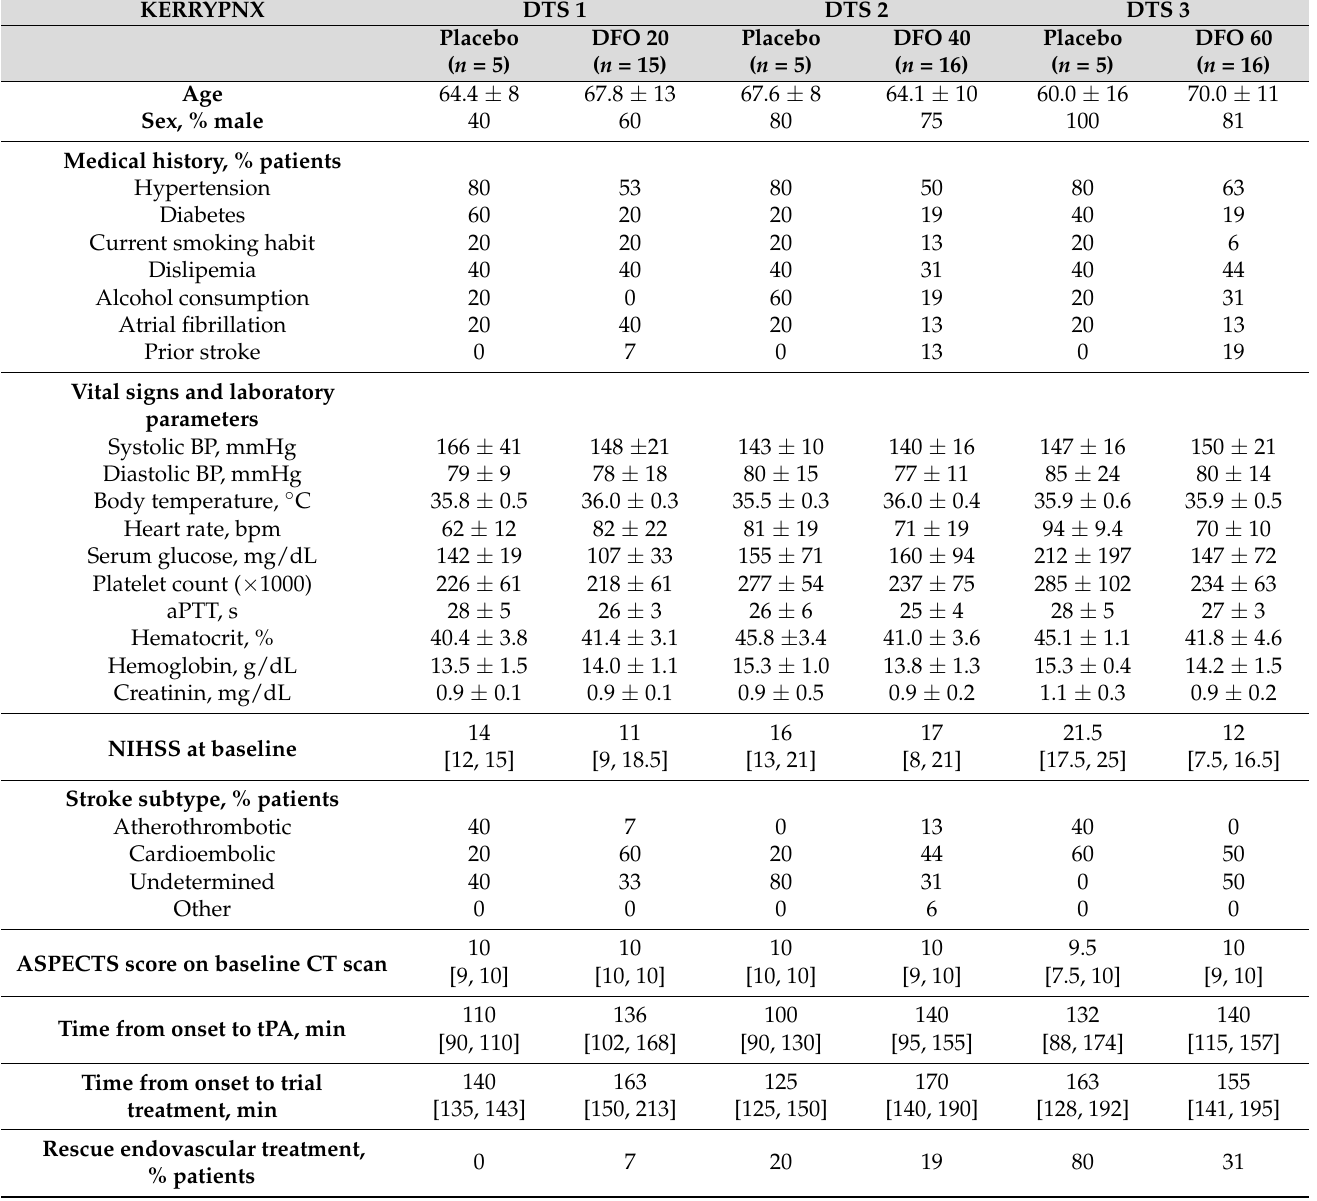
Table 1. Description of the demographic and baseline clinical characteristics in the placebo and DFO group in each